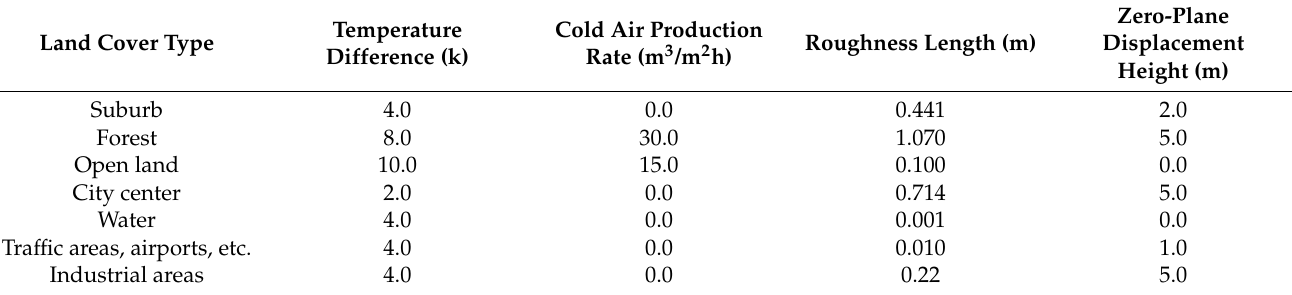
Table 1. Land use types applied for the KALM model and their parameters used for this